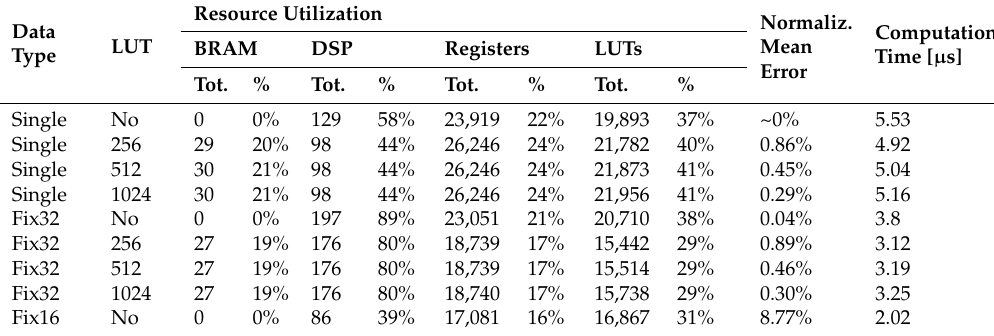
Table 7. NN inference on FPGA: implemented solution results for {8, 16|12|8, 4} topology.